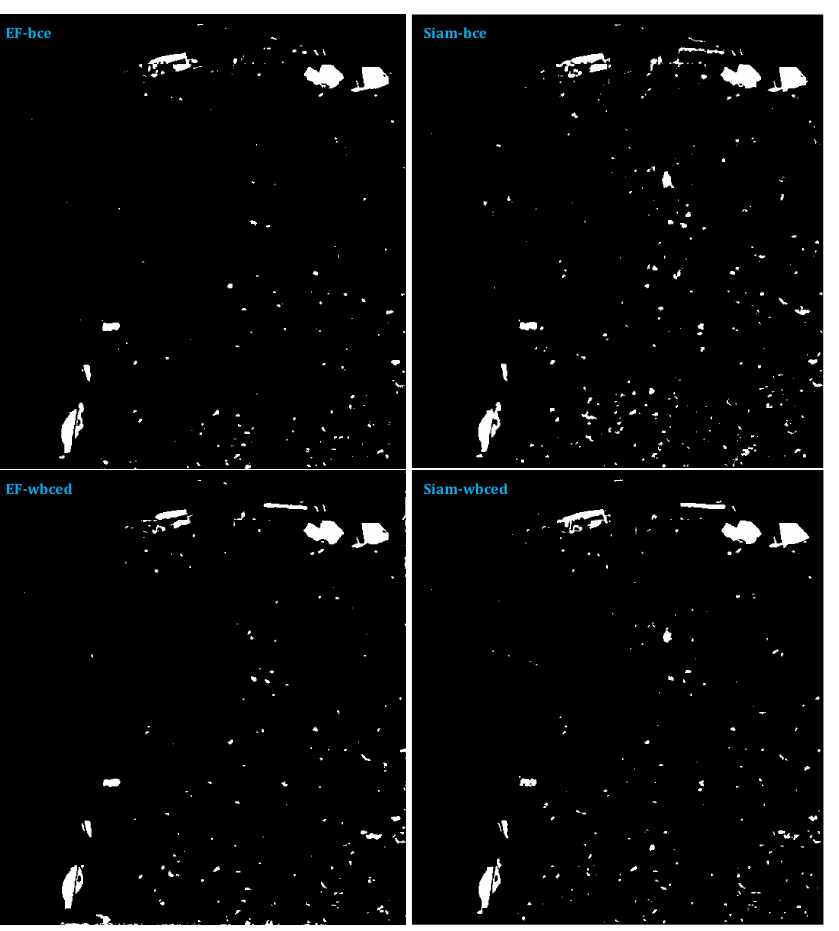
Figure 6. Change maps of the Beirut city obtained by the four segmentation models: EF-bce ( top left ), Siam-bce ( top right ), EF-wbced ( bottom left ), and Siam-wbced ( bottom right